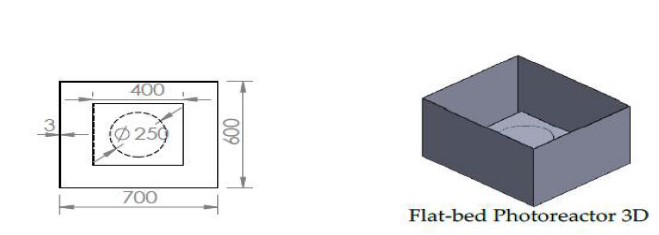
Figure 2. Different views of the dimensions of the photoreactor.